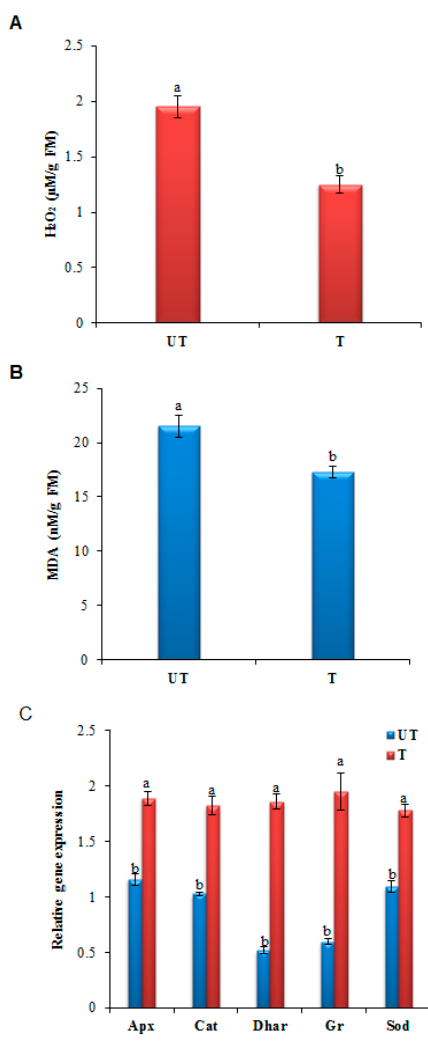
Figure 2. Histograms showing estimated ( A ) H 2 O 2, ( B ) MDA content in P. infestans infected GalUR transgenic (T) and untransformed control (UT) potato leaves, ( C ) genes encoding reactive oxygen species (ROS)-scavenging enzymes, ascorbate peroxidase ( APx ), catalase ( CAT ), dehydroascorbate reductase ( DHAR ), glutathione reductase ( GR ), and superoxide dismutase ( SOD ) in P. infestans infected GalUR transgenic (T) and untransformed control (UT) potato plants. Data are presented as means ± SD of three replicates. Different letters indicate a significant difference at p ≤ 0.05.